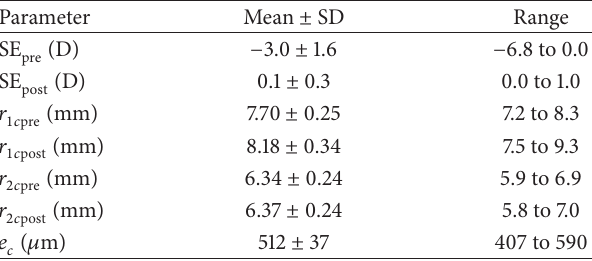
Table 1: Mean ocular features of the eyes evaluated in the current study.